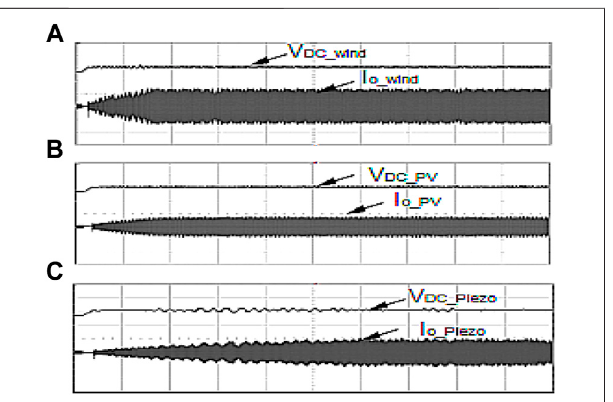
FIGURE 9 | DC power is fed to the 24-V bus